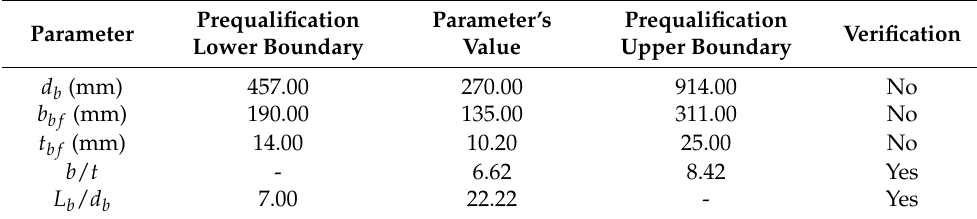
Table 1. Beam’s characteristics vs. prequalification limits.